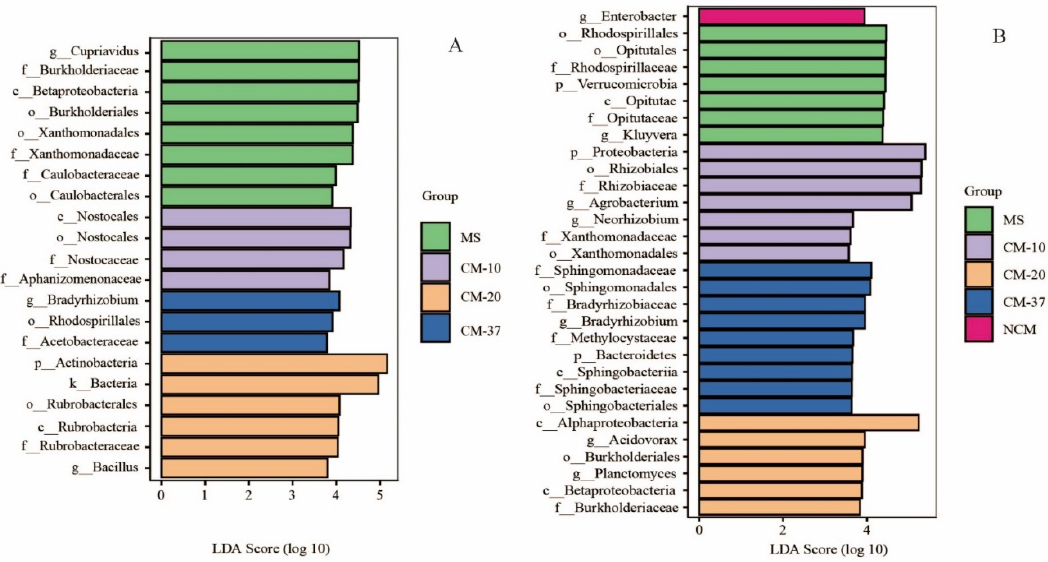
Figure 6. LEfSe analysis of microbial phoD and gcd communities shows taxa with significantly different abundance. ( A ) phoD ; ( B ) gcd . A significance level of 0.05 and a threshold value of 3 were used. MS: moving sand dune; CM-10: 10-year-old Caragana microphylla plantation; CM-20: 20-year-old C. microphylla plantation; CM-37: 37-year-old C. microphylla plantation; NCM: Natural C. microphylla community.